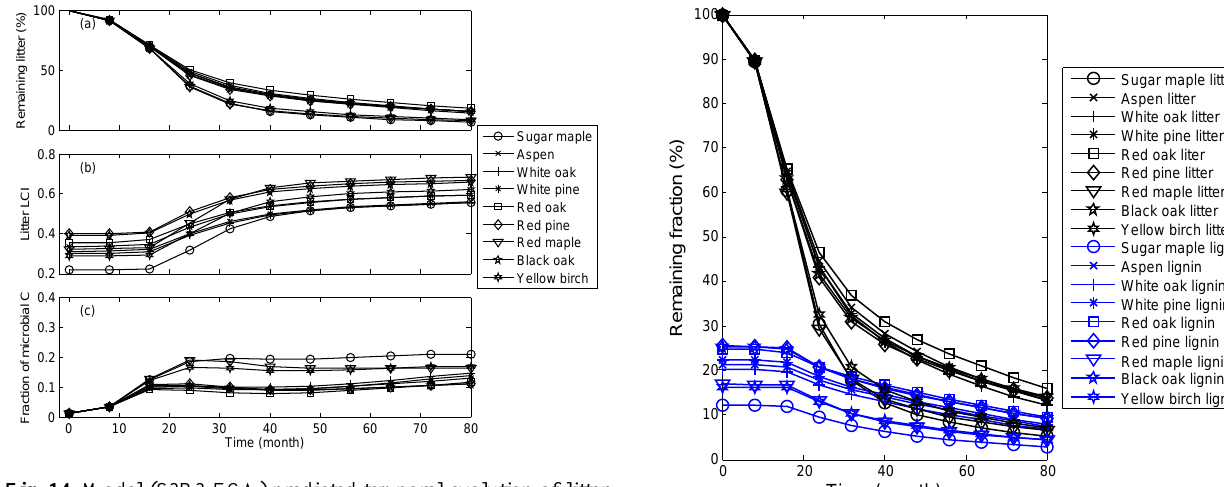
Fig. 14. Model (S3B3-ECA) predicted temporal evolution of litter decomposition dynamics for the 9 different litters in Table 4. The used parameters are in Table 5.